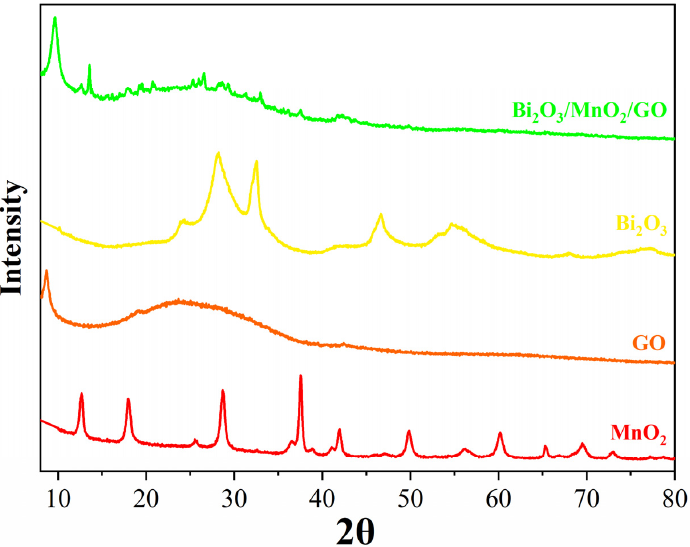
Figure 2. XRD pattern of the GO nanoflakes, dandelion-like α -MnO 2 microspheres, flower-like β - Bi 2 O 3 microspheres, and Bi 2 O 3 /MnO 2 /GO nanocomposites. β -Bi 2 O 3 microspheres, and Bi 2 O 3 /MnO 2 /GO